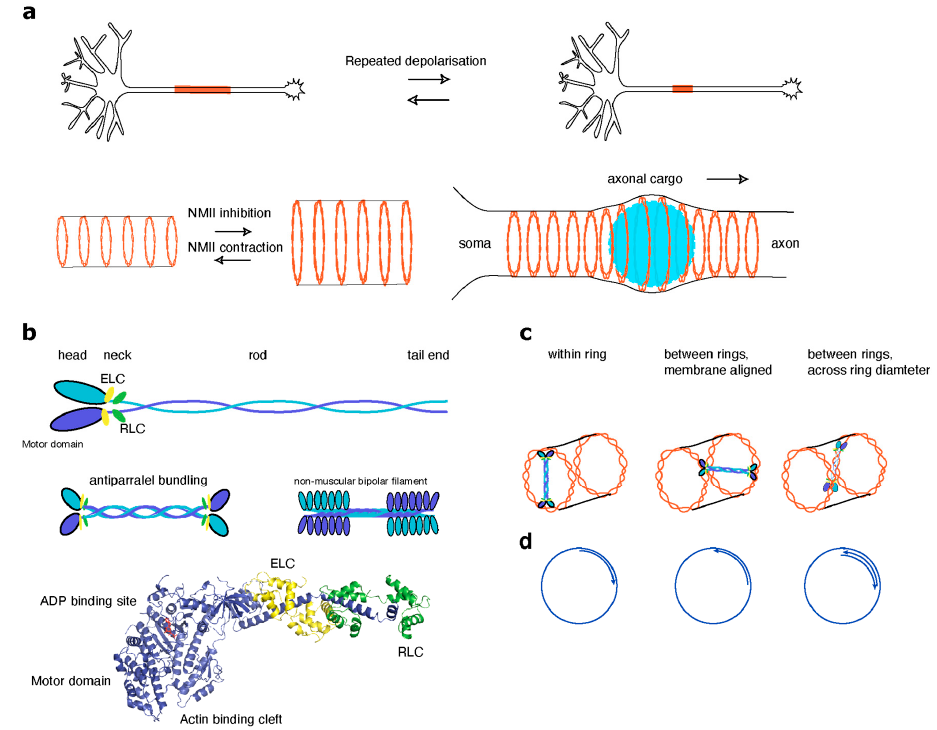
Figure 2. Organization and function of non-muscle myosin II (NMII). ( a , top) Repeated depolarization leads to proximal shortening of the AIS and subsequent extension towards the distal axon. NMII activity is necessary for this process as blebbistatin completely blocks the activity. ( a , bottom) NMII activity controls the axonal diameter. Inhibition of NMII by blebbistatin leads to an increase in axon diameter, indicating that NMII holds the membrane-associated cytoskeleton (MSK) under constant tension. In addition, NMII has been shown to be implicated in cargo trafficking along the AIS. The size of large cargo (e.g., autophagosomes, mitochondria, endosomes or lysosomes) can exceed the diameter of the axon. Passage of this large axonal cargo causes a transient radial expansion of the axon followed by constriction, which depend on myosin II activity. ( b , top) Schematic organization of NMII. NMII exists as a hexamer that consists of two copies each of elongated heavy chains, two regulatory light chains (RLC) and two essential light chains (ELC) that stabilize the heavy chain structure. The heavy chain is composed of an N-terminal motor domain, a neck domain, which interacts with both light chains, an α -helical rod domain and a C-terminal tail. ( b , middle) The hexameric units further bundle both in a parallel and antiparallel manner into bipolar structures that can pull actin filaments together. ( b , bottom) Crystal structure of the motor and neck domains of NMII interacting with ELC and RLC. The motor domain contains the actin binding cleft where NMII interacts with actin. Shown in red is ADP bound at the nucleotide binding site. Cycling from ATP to ADP at the nucleotide binding site leads to conformational changes in the actin binding cleft, which modulate the interaction of NMII with actin. ( c ) Models of a possible spatial relationships between NMII and actin rings. The length of an active two-headed myosin motor complex is around 300 nm, while the distance between actin rings is only 190 nm. ( c , left) NMII crosses the diameter of a single actin ring. Alternatively, NMII could cross link two neighboring rings with an angle deviant from 90°, which can be achieved when myosin motors connect neighboring actin rings in a one-dimensional lattice (as spectrin) ( c , middle) or across the axonal volume ( c , right). ( d ) Polarity of actin filaments in